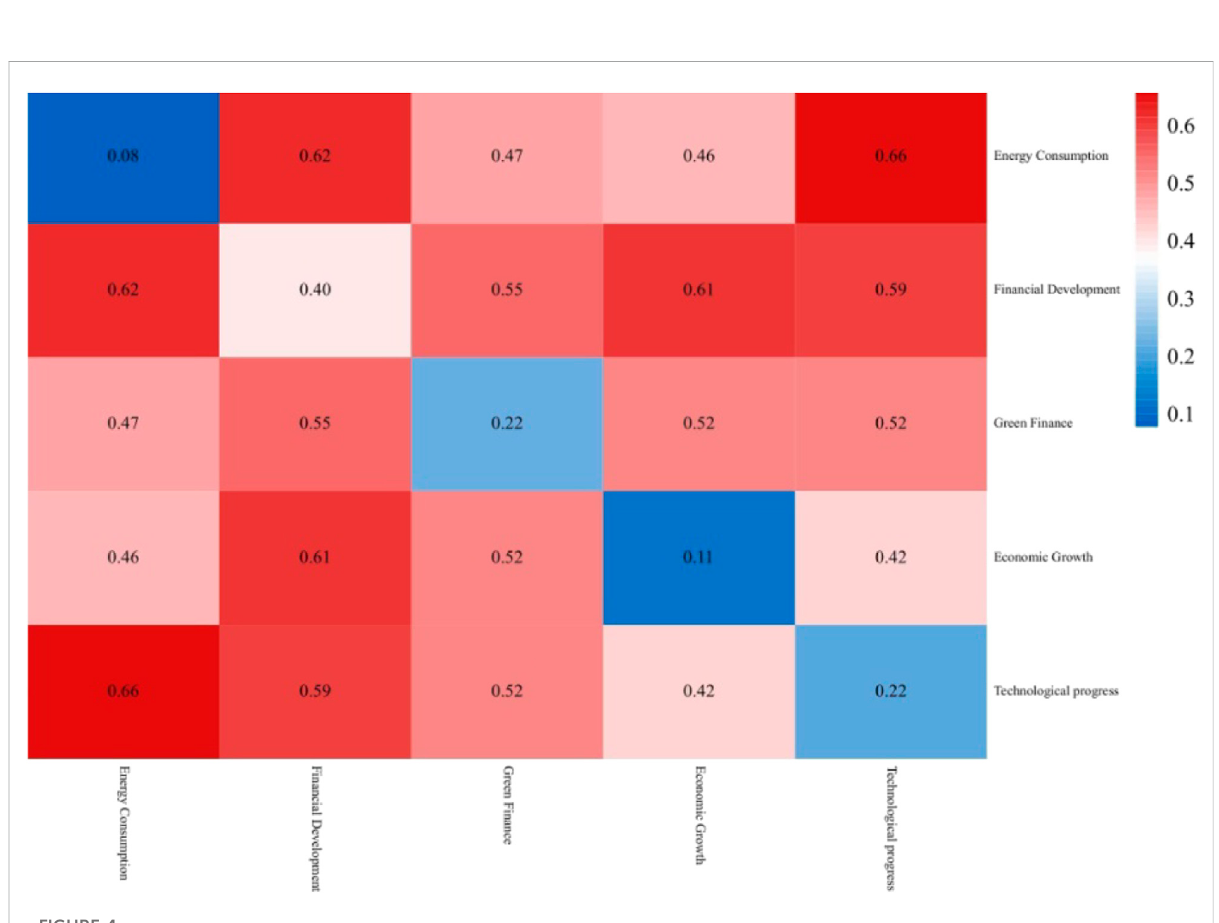
FIGURE 4 Interaction